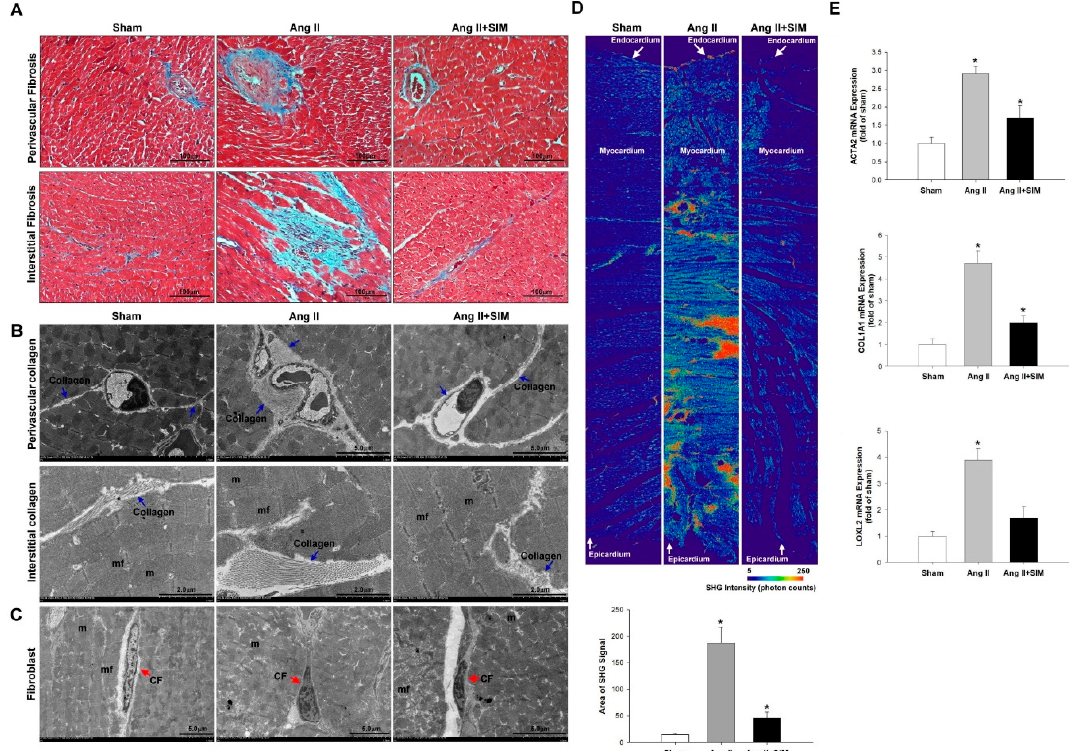
Figure 1. Simvastatin suppresses in vivo angiotensin (Ang) II-mediated collagen deposition, fibrosis, and collagen-associated protein expression. Male Sprague-Dawley rats were treated with (Ang II, 1 mg/kg/day) or Ang II + simvastatin (SIM, oral, 10 mg/kg) for 28 days. Perivascular and interstitial fibrosis ultrastructures (blue color) were determined using Masson’s trichrome staining. ( A ) The collagen fibers are shown in the representative images (blue) ( n = 6). Perivascular and interstitial collagen fiber expression (blue arrows) ( B ) and quantification by transmission electron microscopy (TEM) analysis are shown (Supplemental Figure S1A,B). The cardiac fibroblast (CF) ultrastructures (red arrows) were determined using TEM analysis ( C ) ( n = 6) (mf, myofibril; m, mitochondrial; CF, cardiac fibroblast). Cardiac collagen deposition and arrangement from endocardium to epicardium were identified and quantified using second-harmonic generation (SHG) microscopy ( D ) ( n = 3). * p < 0.05 vs. the control from three independent experiments. The fibrotic associated genes: ACTA2 , COL1A1 , and LOXL2 expression were analyzed using real-time PCR and normalized by β –actin ( E ). For all comparisons, * p < 0.05 vs.